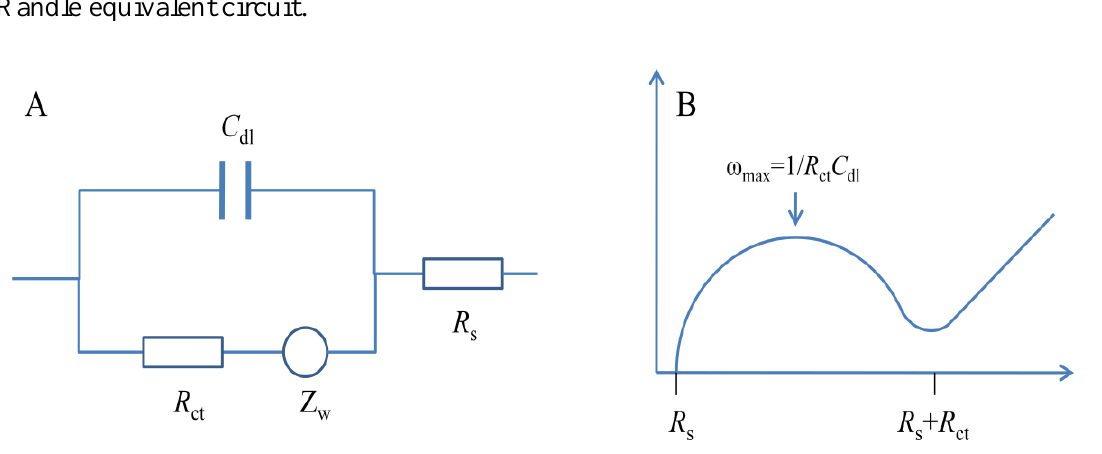
Figure 1. ( A ) the typical Nyquist diagram for the AC impedance measurements; ( B ) the Randle equivalent